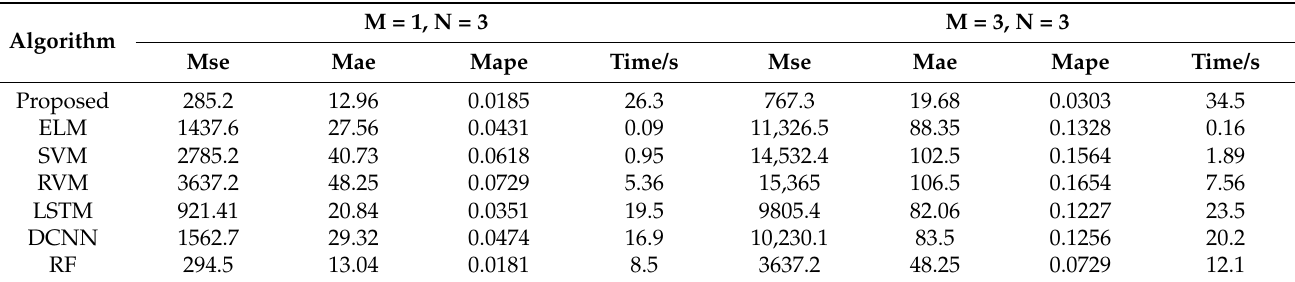
Table 3. Comparison between proposed model and state-of-the-art